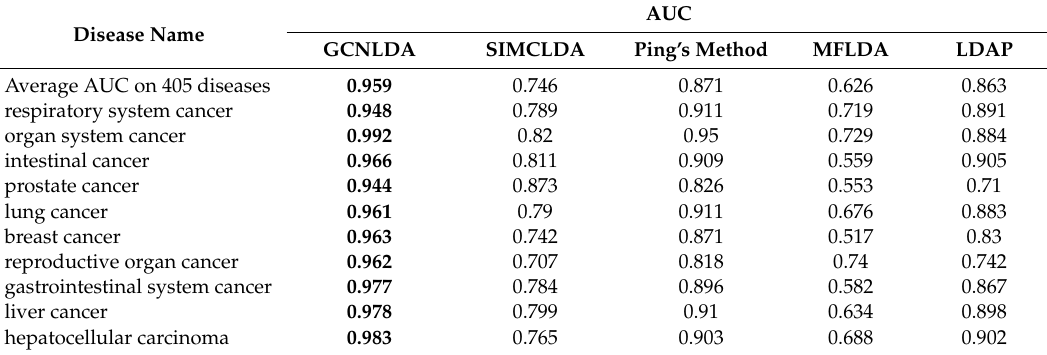
Table 2. AUPRs of GCNLDA and other methods for all the diseases and 10 well-characterized diseases. Disease Name